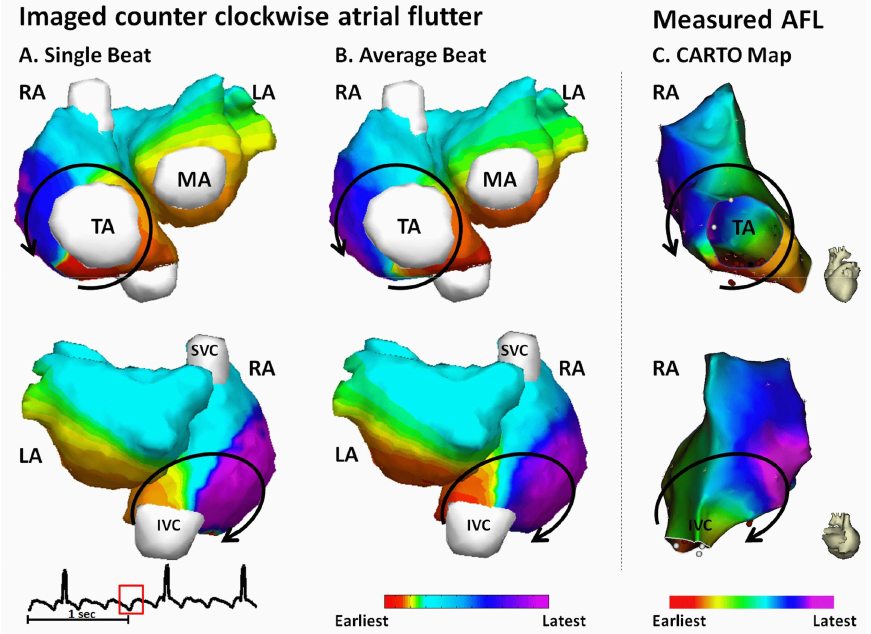
Fig 4. Activation maps for patient AX4. (A) Noninvasively imagedAFL reentry circuit from one single beat. Solid black lines represent propagation wavefronts in RA. (B) Average AFL reentry circuit. (C) CARTO activation map. AFL = Atrial flutter; IVC = Inferior vena cava; LA = Left atrium; MA = Mitral annulus; RA = Right atrium; SVC = Superior vena cava; TA = Tricuspid annulus.